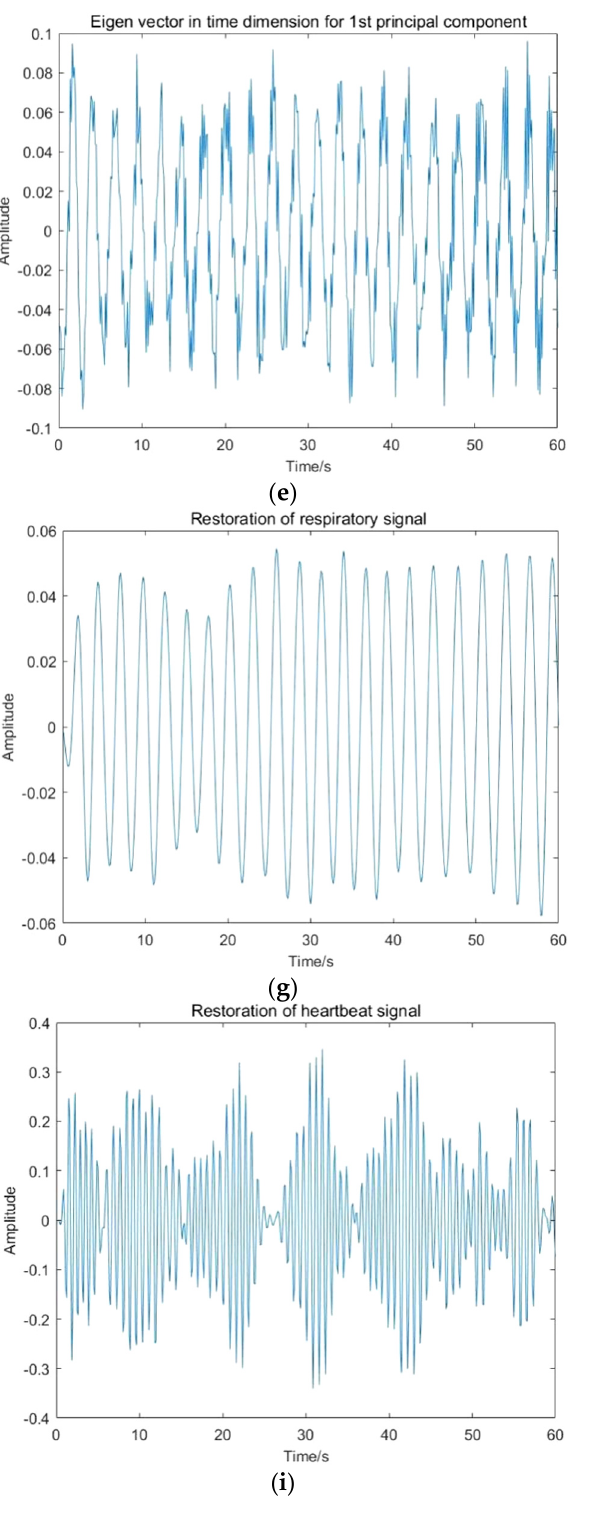
Figure 26. Results of essential steps for experiment group 3: ( a ) Radar raw data; ( b ) Radar data after preprocessing; ( c ) The relative principal component; ( d ) Spatial eigenvector; ( e ) Temporal eigenvector; ( f ) Energy entropy; ( g ) Restoration of respiratory signal; ( h ) Respiratory signal spectrum; ( i ) Restoration of heartbeat signal; ( j ) Heartbeat signal spectrum.